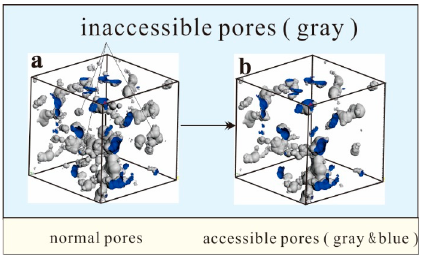
Figure 5. Accessible pores and inaccessible pores. ( a ) normal pores ( b ) accessible pores.